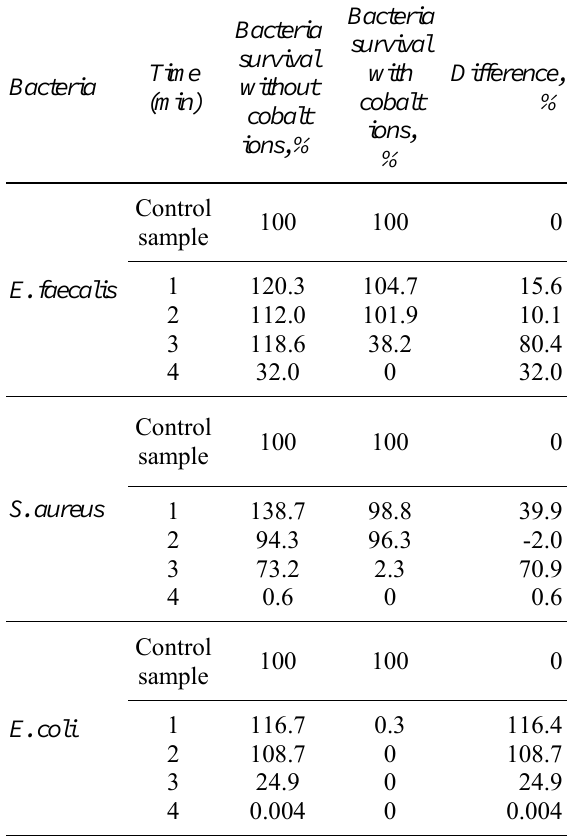
Table 2: Bacterial survival of E. faecalis , S. aureus , and E. coli at various times using microwave heating in the presence and absence of iron